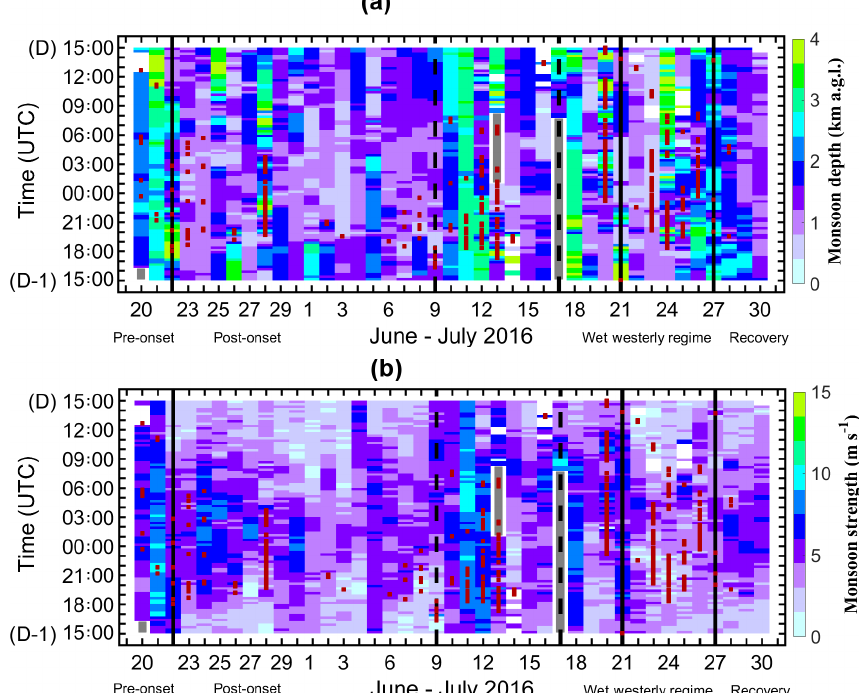
Figure 2. Diurnal evolution of the monsoon flow (a) thickness and (b) strength at Savè from 15:00UTC on day D-1 to 15:00UTC on day D during the course of the 20 June through 30 July 2016 time period. Solid black vertical lines delimit the different phases of the monsoon described by Knippertz et al. (2017). Dashed vertical lines indicate the vortex phase included in the post-onset phase. White windows indicate periods for which the monsoon flow was not defined (i.e., a wind direction beyond the 135–270 ◦ sector). Grey windows indicate missing data. Red squares indicate rainy